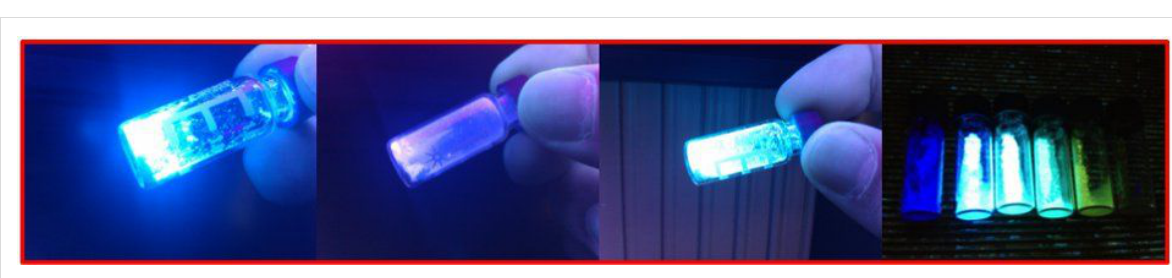
Figure 2: Selected examples of gold–NHC amide complexes under UV light ( λ = 366